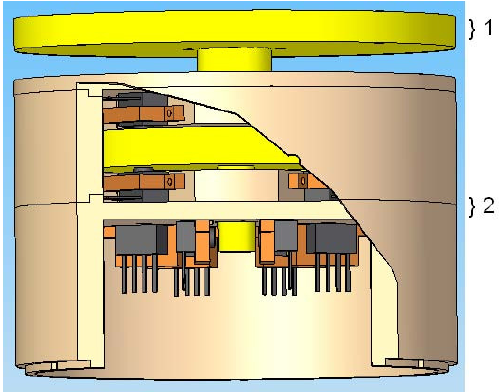
Figure 3. Design of the 3D dynamic forces/moments sensor: (1) Moving part; (2) Fixed